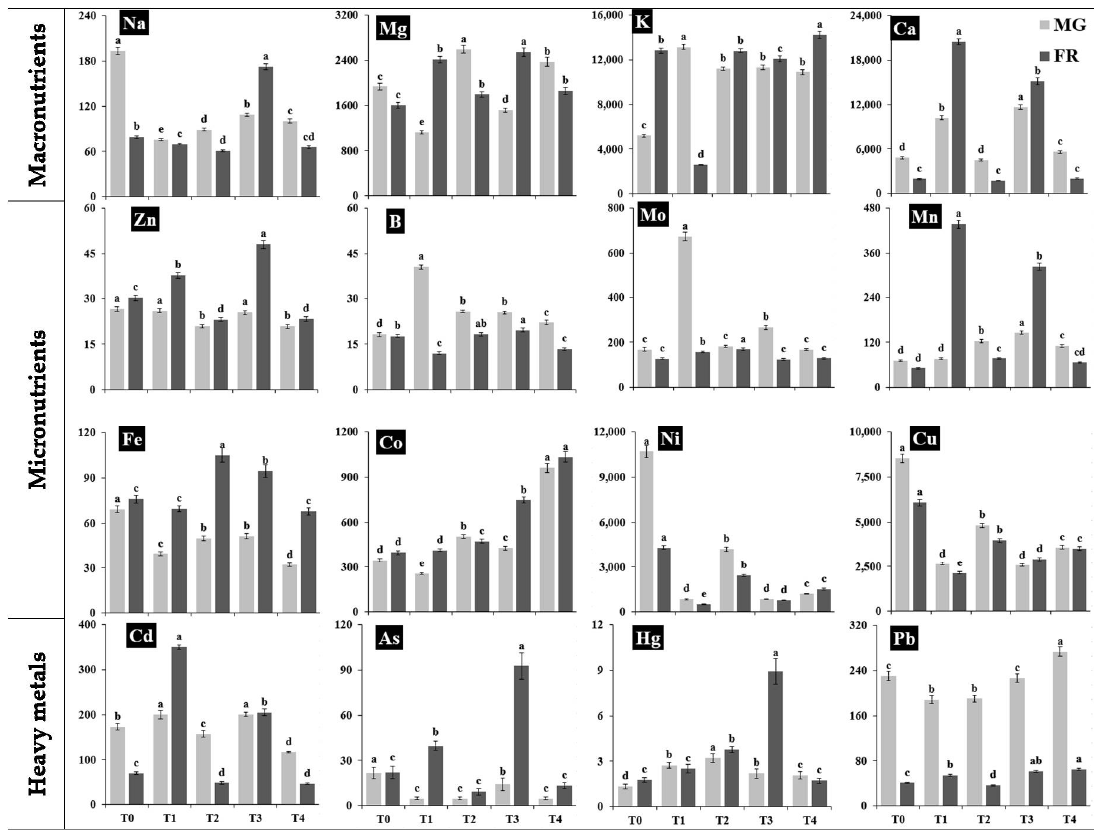
Figure 3. Level of mineral nutrients and heavy metals in loquat fruit pulp as affected by the exogenous application of Mg, Zn, and B. Different letters indicate a significant difference among treatments for each series according to Fisher’s least significant difference test at α = 0.05. Vertical bars indicate average ± standard error (four replicates, p ≤ 0.05). T 0 —control; T 1 —2% MgSO 4 .7H 2 O, T 2 —0.1% ZnSO 4 .7H 2 O, T 3 —0.2% Na 2 B 4 O 7 .10H 2 O and T 4 —T 1 +T 2 +T 3 (1:1:1), MG—mature green stage, FR—fully ripe stage.